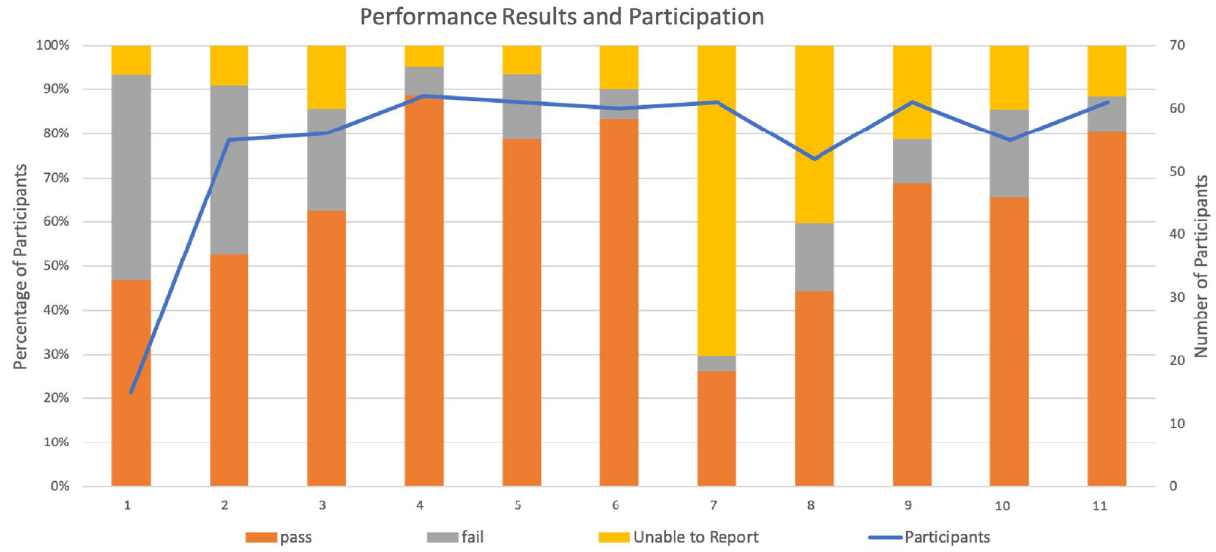
Figure 2. Performance of all participants. Indicated are pass, fail, and unable to report percentages for 11 EAQ sessions. The blue line indicates the number of participants per session. Unable to report means that these labs registered for a session but did not send results due to no login/broken instrument/no reagents/expired reagents, therefore these labs did not run the